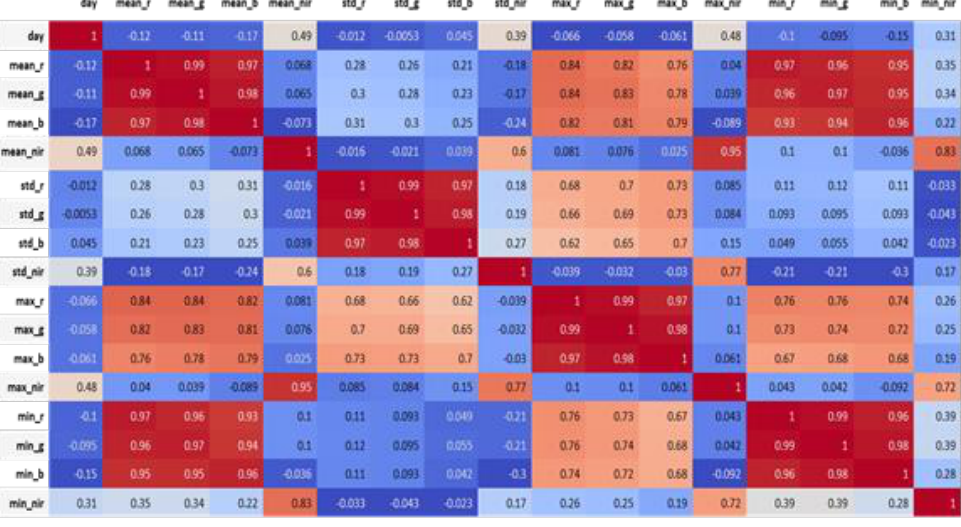
Figure 17. Correlation between spectral features and cabbage growth stages. Table 1. Correlation coefficients between spectral features and cabbage growth stages.